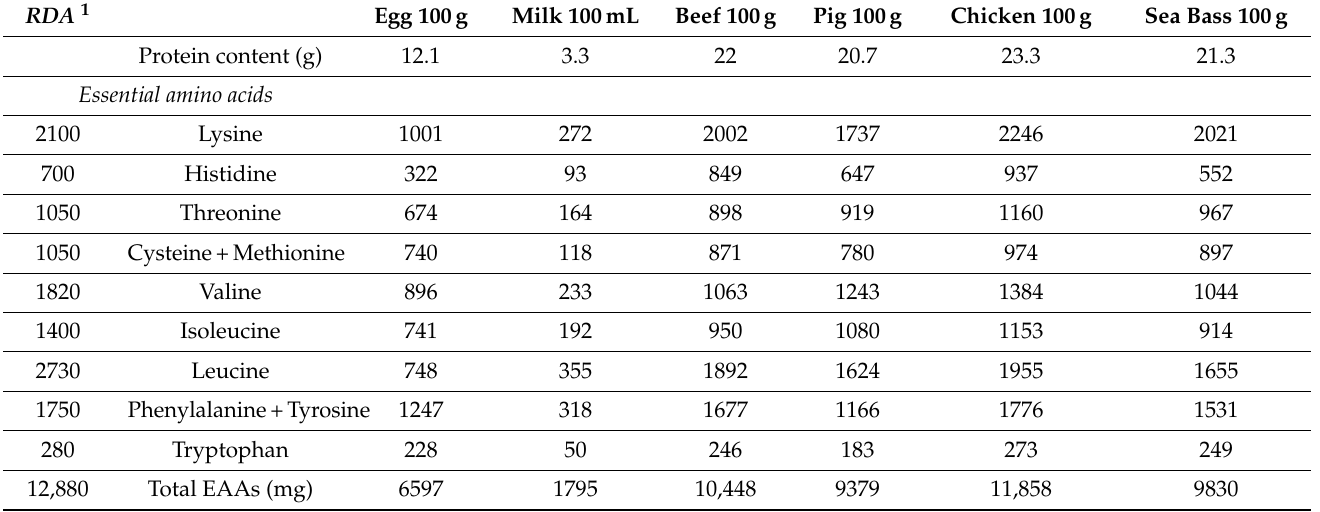
Table 4. Recommended daily doses for a 70 kg male, and AAs in various foods: animal source foods. Reprinted with permission from [88].